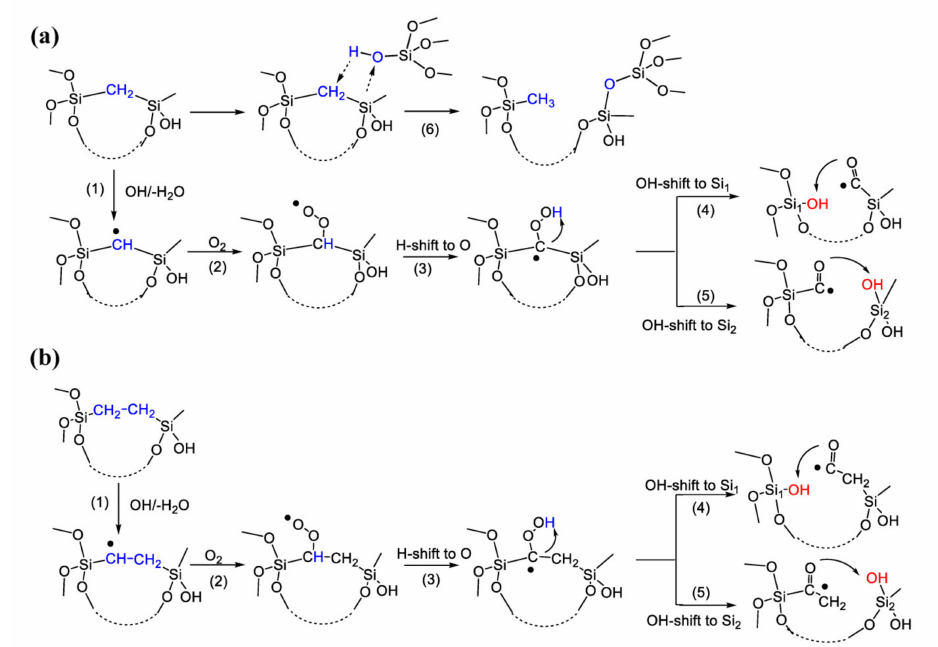
Figure 14. Calculated energetically favourable possible reaction pathways leading to Si–C bond scission in model polymers with –Si–CH 2 –Si– ( a ) and –Si–CH 2 –CH 2 –Si– ( b ) bridges. Structures of model polymers are simplified for clarity. Reaction parameters ∆ H and ∆ G are given in Table 3.